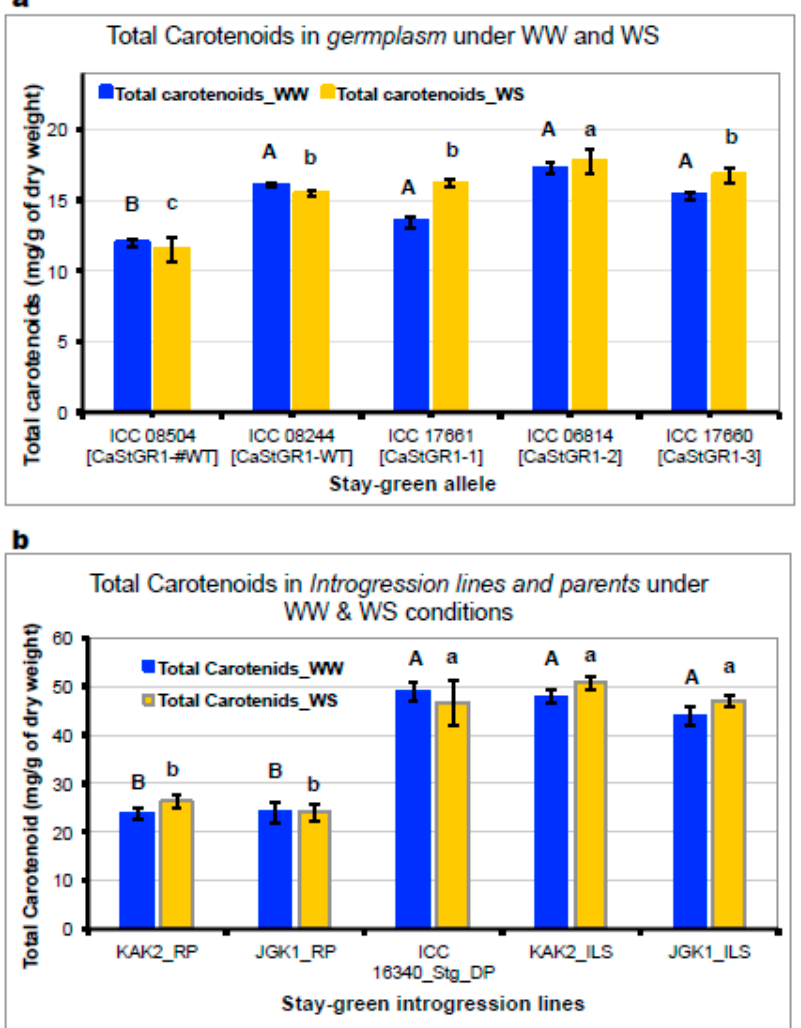
Figure 9. Variation in ( a ) seed total carotenoids content in germplasm [ICC 08,504 (CaStGR1-#WT), ICC 08,244 (CaStGR1-WT), ICC 17,661 (CaStGR1-1), ICC 06,814 (CaStGR1-2) and ICC 17,660 (CaStGR1-3)] and ( b ) stay green chickpea introgression lines (ILs) with different genetic background under well-watered (WW) and water-stressed (WS) conditions. During detached leaf green assay, ICC 08504-CaStGR-1-#Wild type showed yellow colour fully in all leaflets. By contrast, ICC 08244-CaStGR-1-Wild type showed semi-green colour leaflets. Genotypes with CaStGR1-1 (ICC 17661), CaStGR1-2 (ICC 06814) and CaStGR1-3 (ICC 17660) showed completely green colour in all the leaflet during detached leaf green assay In both graph (a) and (b), closed bars represents WW and open bars are represents WS. Each data points represents the means (± SE) of five replicates per genotype. Data were used to draw a bar graph for all tested genotypes. Bars with different capital letters (well water-WW) and small letters (water stressed-WS) alphabets are significantly different ( p < 0.05) and same letters represents non-significant.